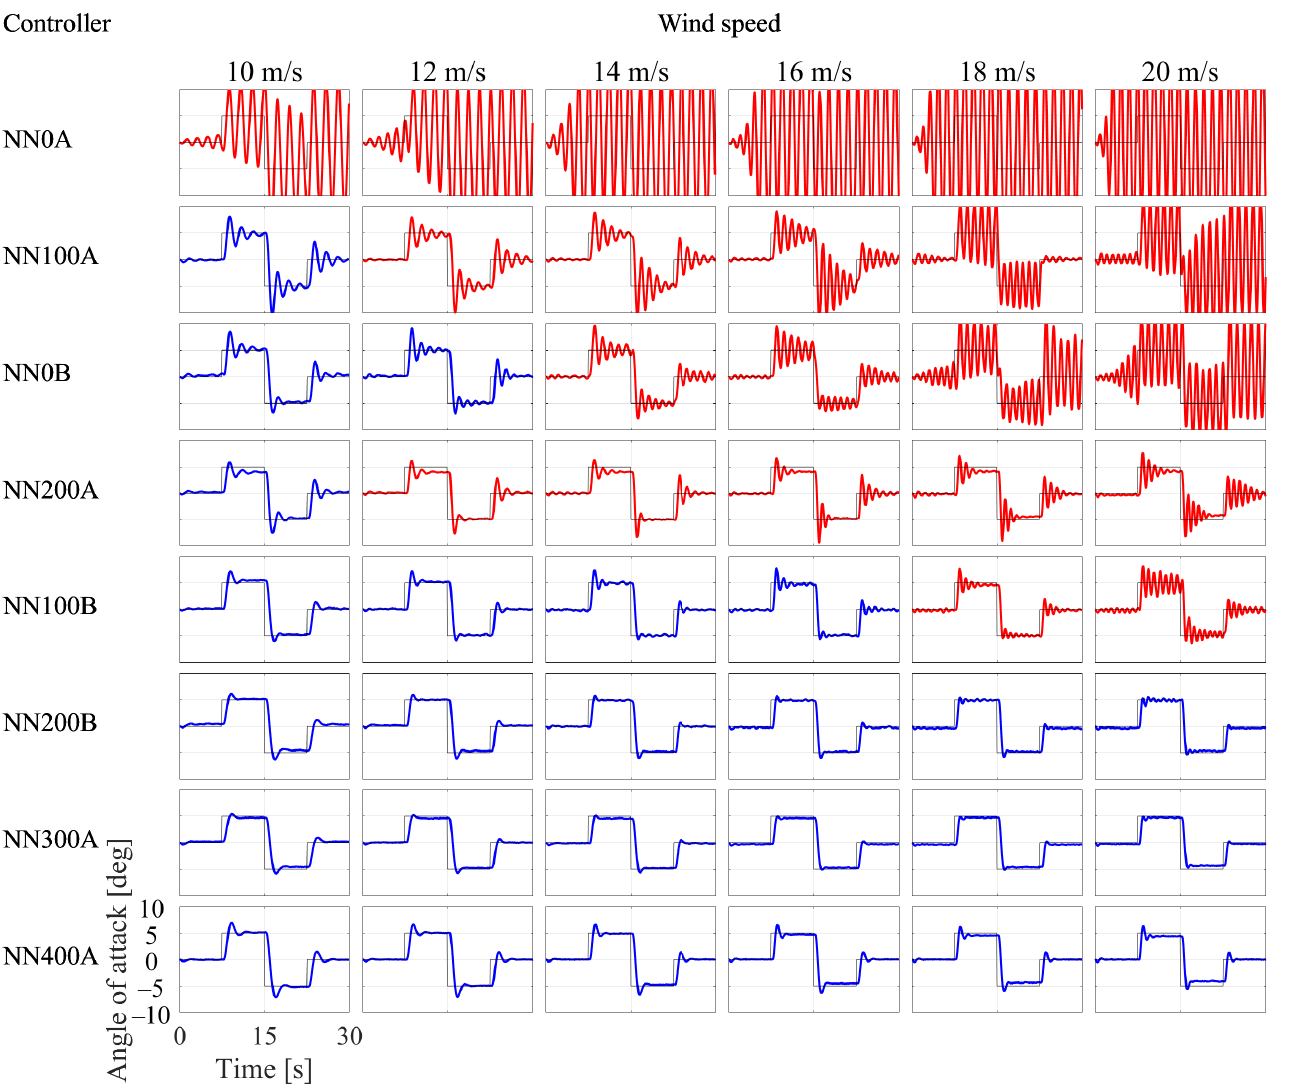
Figure 11. Simulated pitch control results. A time delay t 0 = 250ms was applied. Wind speeds were from 10m/s ( left ) to 20m/s ( right ). The controllers are ordered from top to bottom in the order of theoretical performance in Figure 7. The vertical and horizontal axes correspond to the angle of attack and time, respectively. The target angle-of-attack schedules are shown with black lines. Red plots indicate the results where fluctuating behaviour was observed in the experiment as seen in Figure